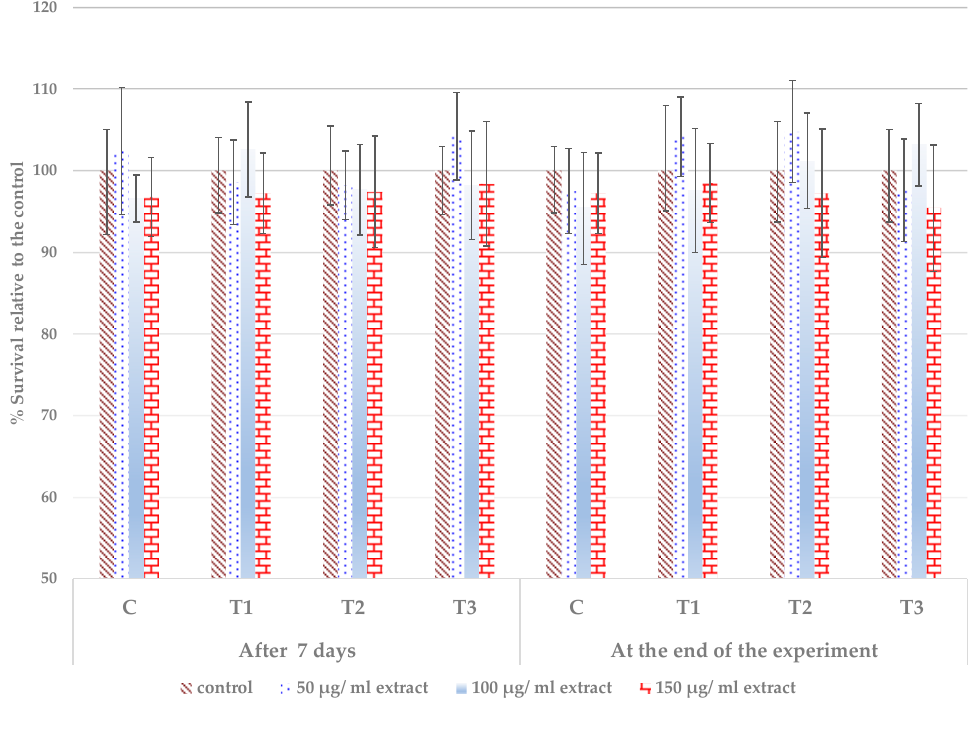
Figure 6. Mouse fibroblast NCTC L929 cell viability after incubation for 48 h with different concentrations of a hydroalcoholic extract of aerial parts of the P. caerulea plants sampled after seven days from the first treatment and after 60 days from the first treatment with plant biostimulants. C — plant control (no treatment with plant biostimulants, treated only with water); T1—foliar treatment with the Trichoderma consortium suspension, 10 6 cfu/mL, equiv. to 10 11 spores/ha; T2—foliar